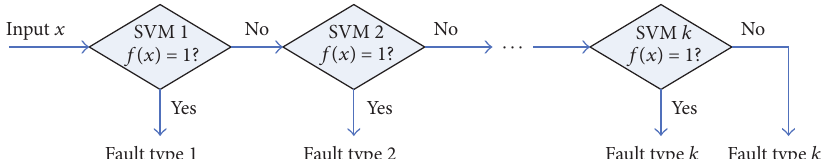
Figure 3: “One to others” multiclass SVM classifier.